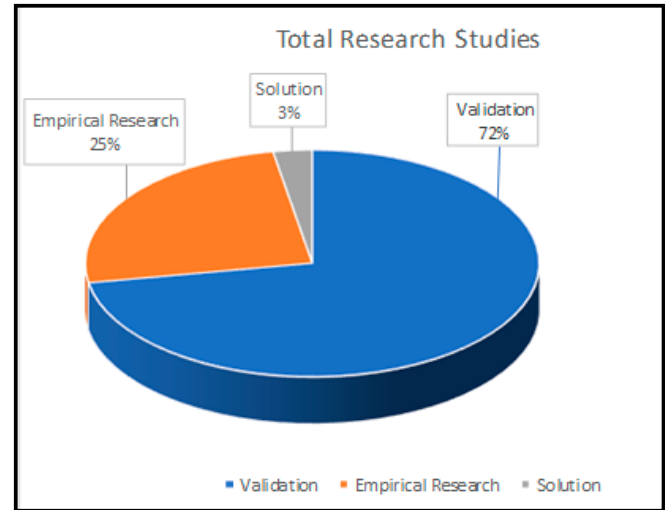
Figure 3. Number of studies categorized into different research types.